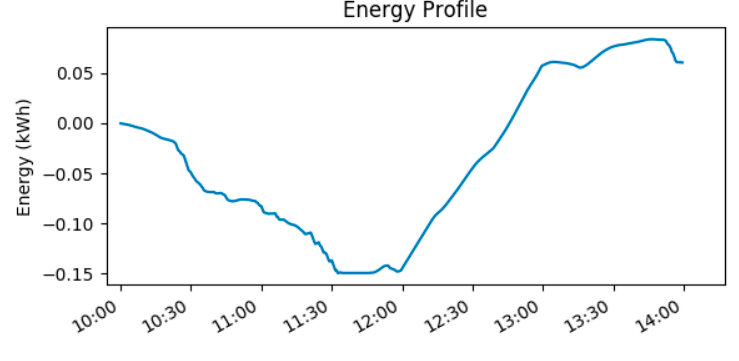
Figure 12. Energy profile. Figure 12. Energy